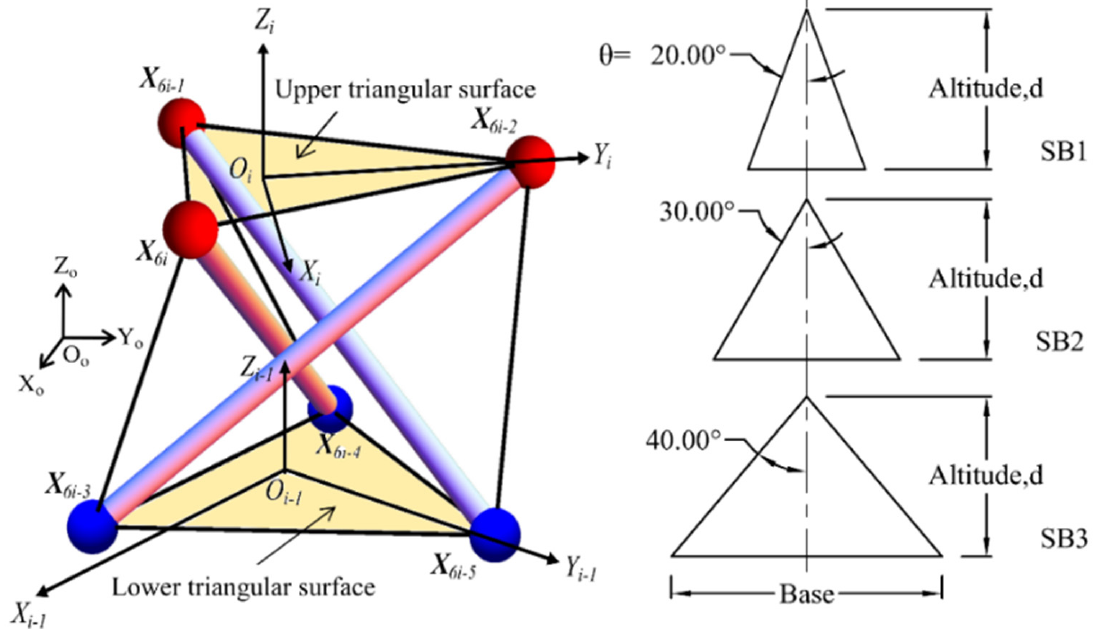
Figure 2. Different sizes of typical triangular cells for spine biotensegrity models.